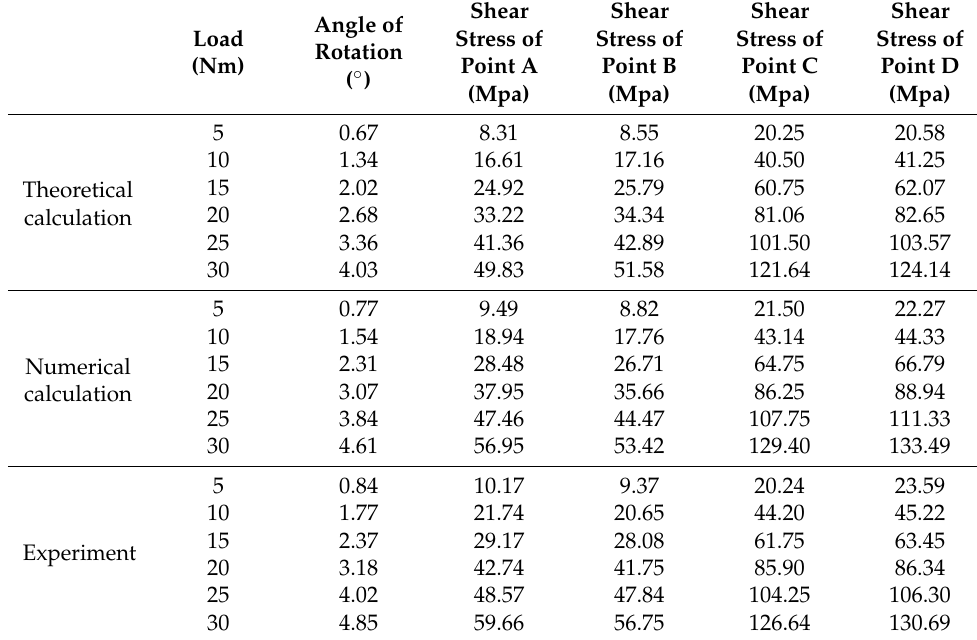
Table 1. Torsional mechanical characteristics of the thin-walled bar with an open cross-section.